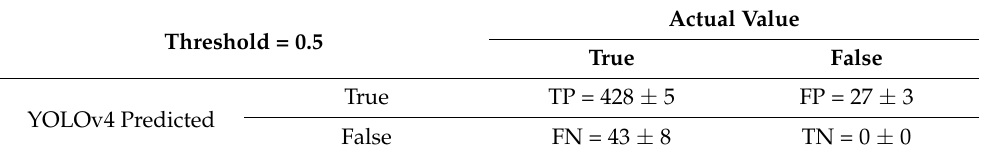
Table 1. Confusion matrix of the testing results.